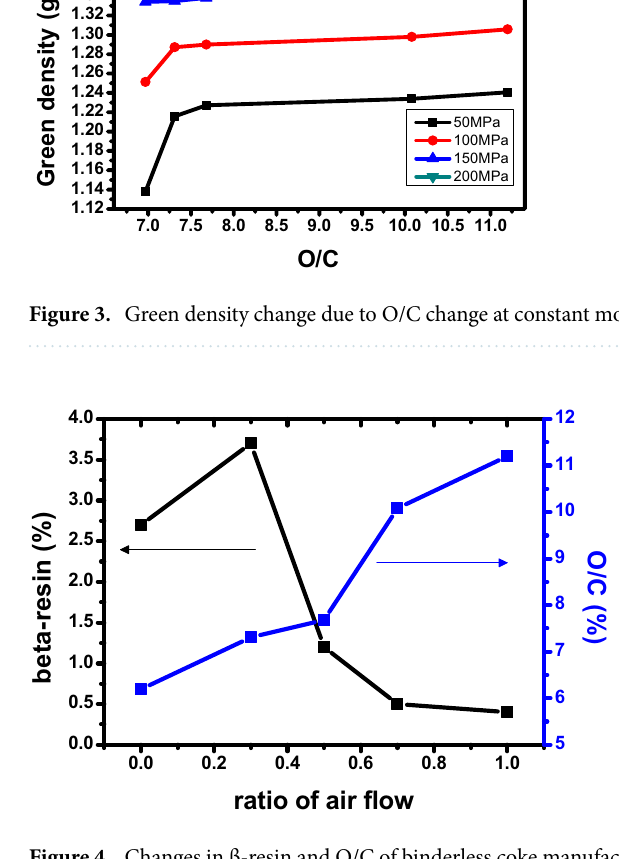
Figure 4. Changes in β-resin and O/C of binderless coke manufactured based on the air flow ratio (N 2